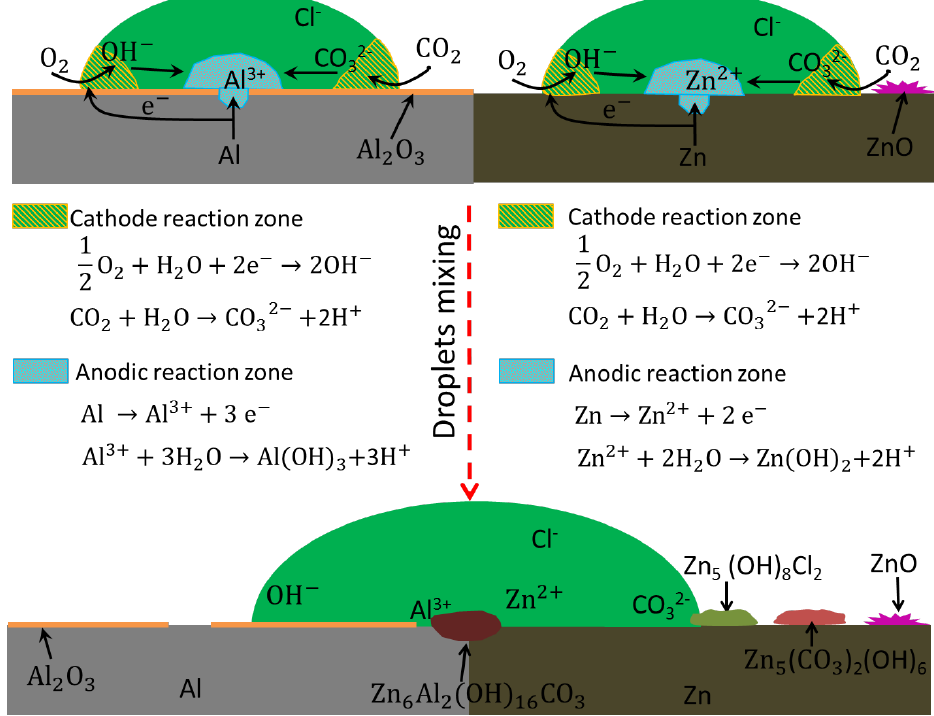
Figure 8. Diagram of the synergistic corrosion process of the Zn–Al composite coating.